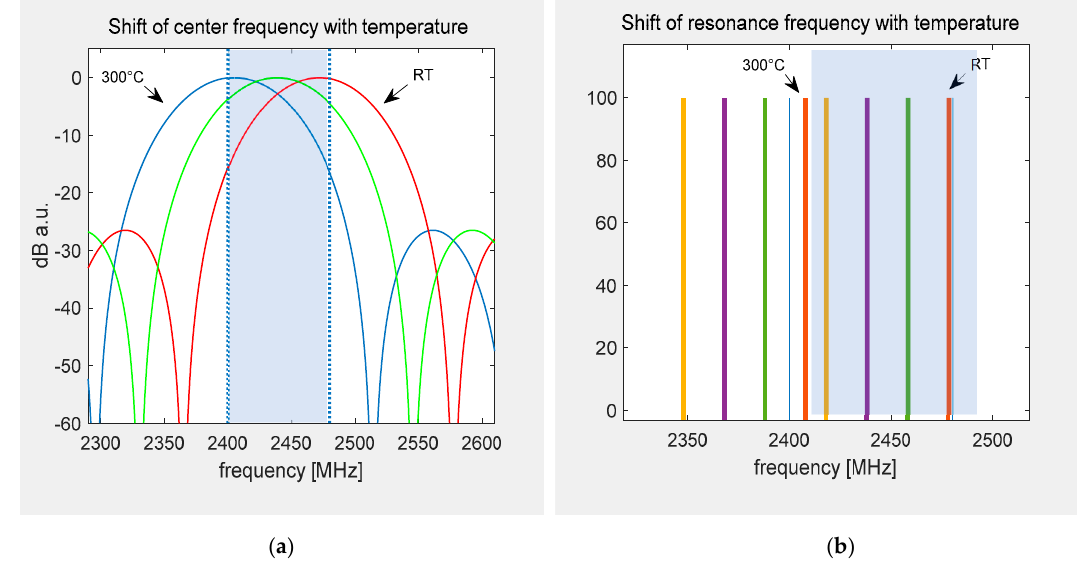
Figure 1. Sketch of the frequency shift due to an operation temperature of 300 ◦ C with respect to the ISM-band for delay lines and resonators: ( a ) While only a part of the transfer function stays within the band at RT and 300 ◦ C (red, blue), the devices can still be interrogated. The optimal operation point is set to 150 ◦ C (green). ( b ) Using resonators, only one (red) stays in the band. The other devices marked as green, violet, and yellow get shifted out of the band when the temperature shift of ~280 ◦ C is applied.